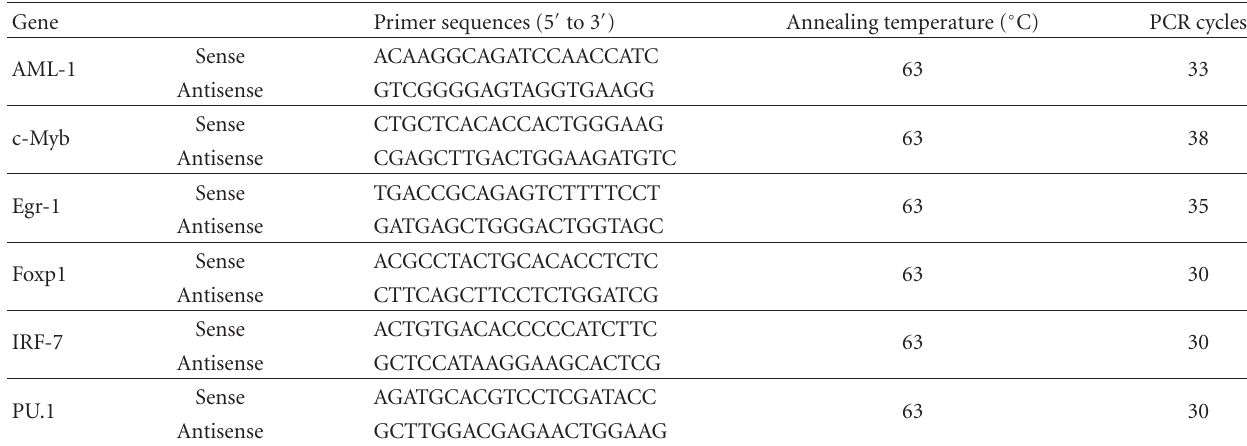
Table 1: Primer sequences and PCR